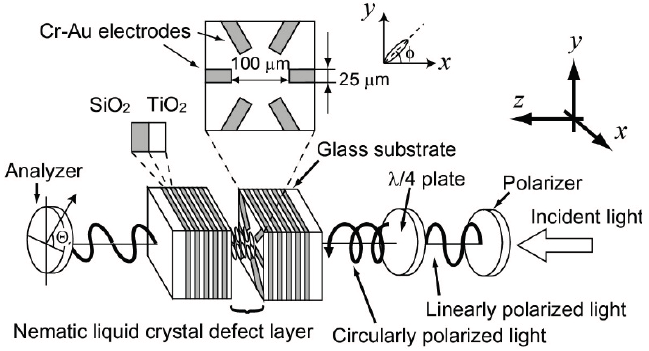
Figure 1. Experimental set-up and a schematic view of a 1D PC with a NLC defect